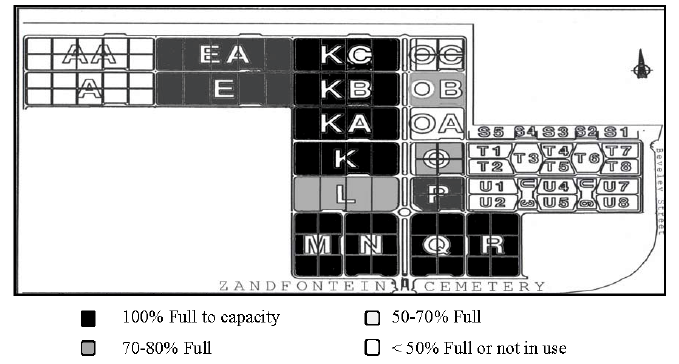
Figure 2. Burial zones in Zandfontein